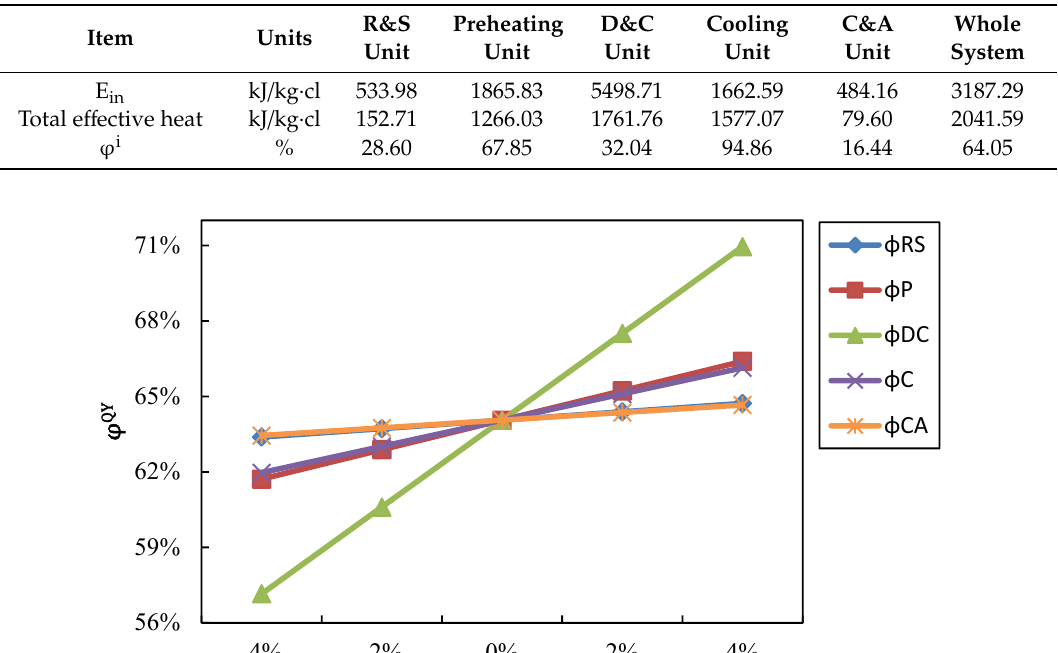
Table 4. Main parameters of the production line.